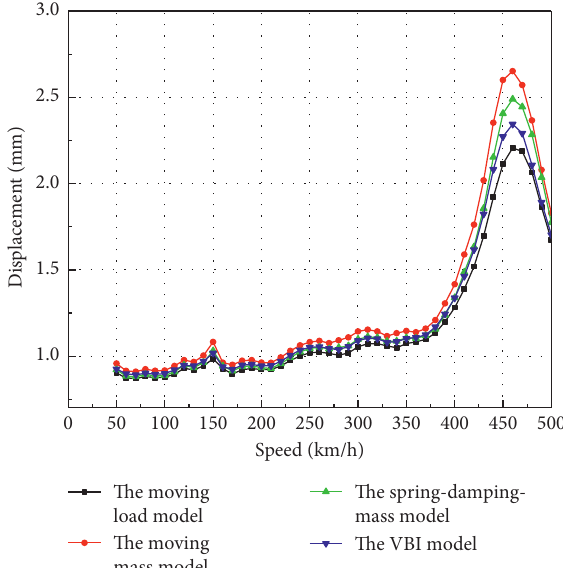
Figure 10: The maximum displacement of the bridge midspan under the four models at a speed of 460km/h.